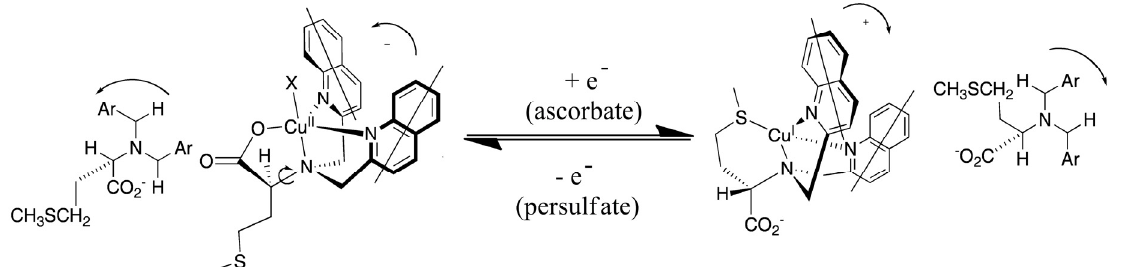
Figure 18. Redox-induced inversion of helicity as a result of the presence of